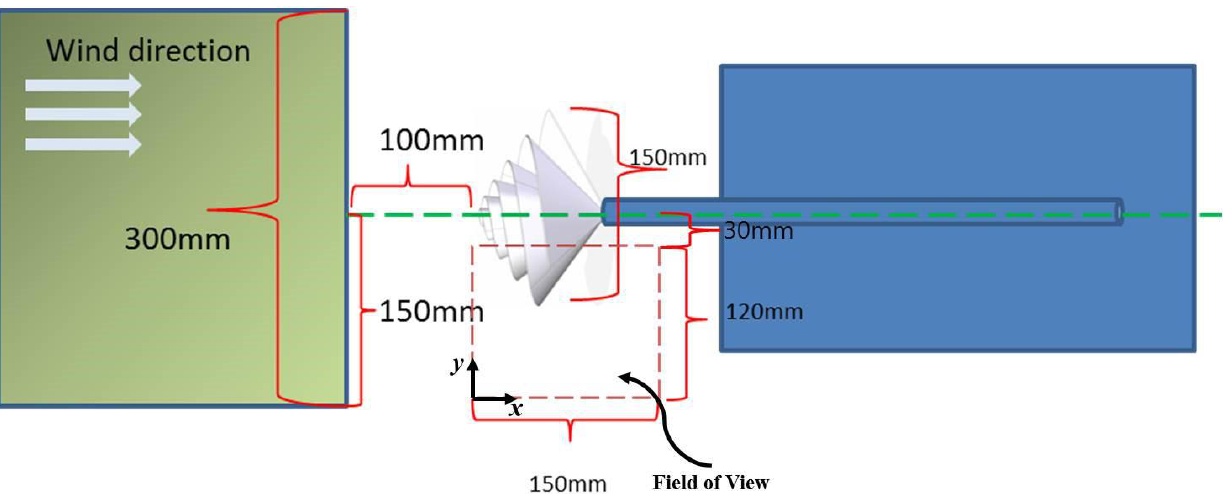
Figure 5. Experimental setup for the PIV measurement and Field of